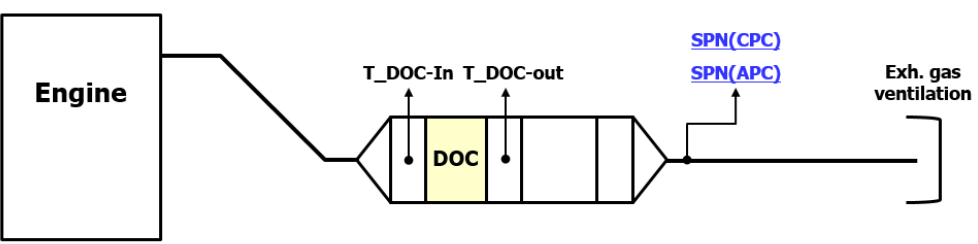
Figure 5. Exhaust gas aftertreatment system layout consisting a DOC. DOC = Diesel Oxidation Catalyst; SPN = Solid Particle Number; APC = AVL Particle Counter; CPC = Condensation Particle Counter.